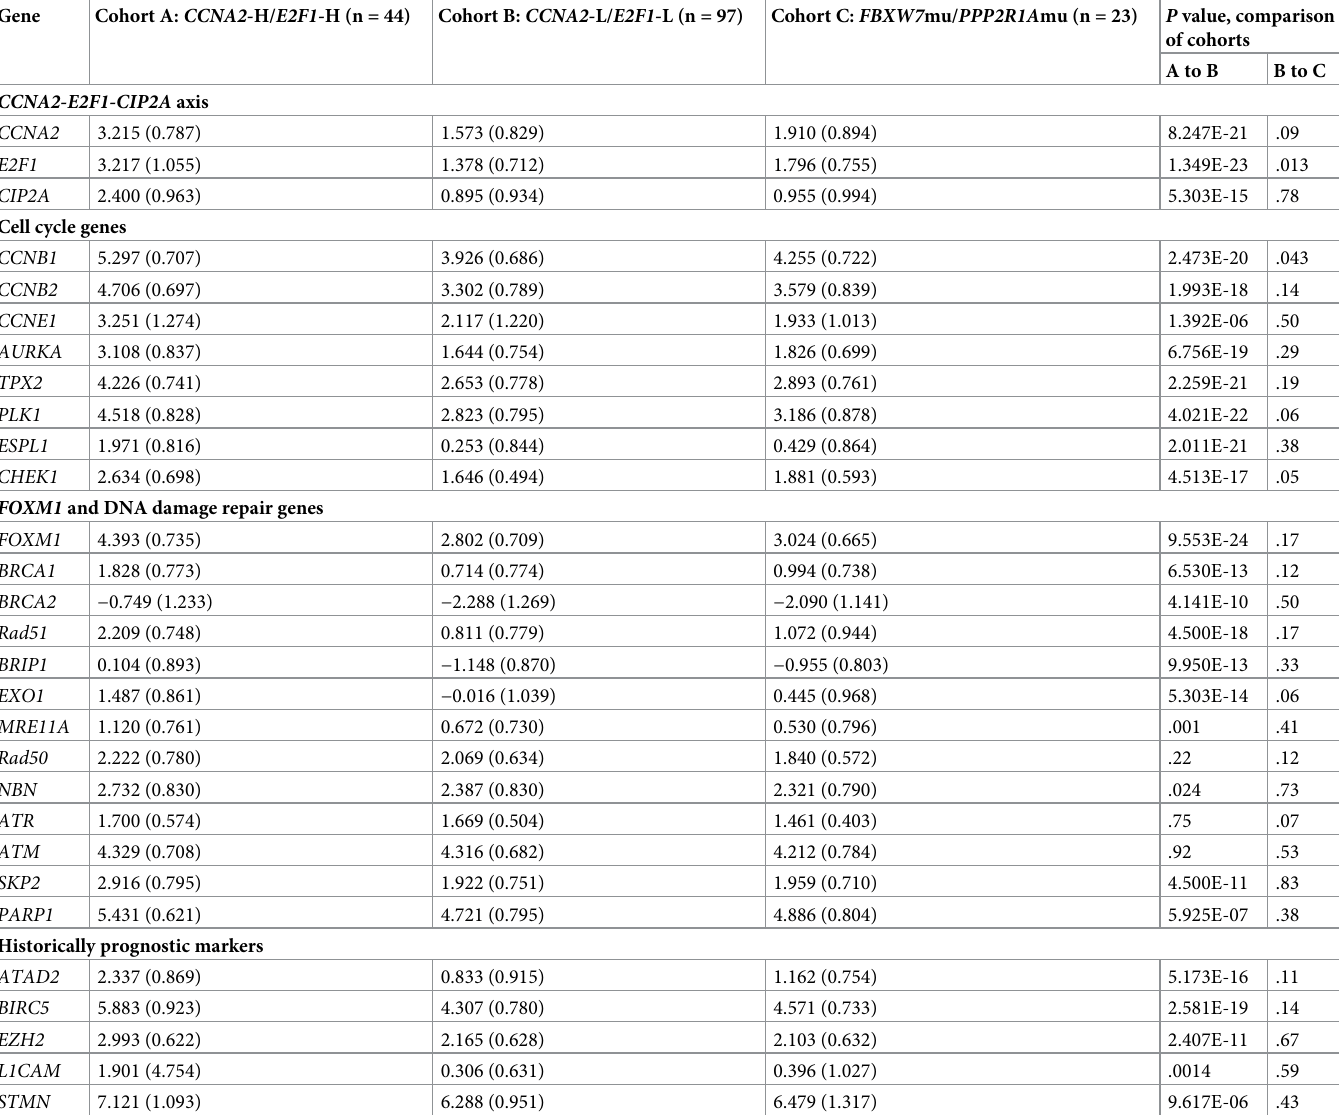
Table 2. Gene log 2 mRNA expression as a function of molecular high- and low-risk endometrioid endometrial cancer cohorts a . Gene Cohort A: CCNA2 -H/ E2F1 -H (n =